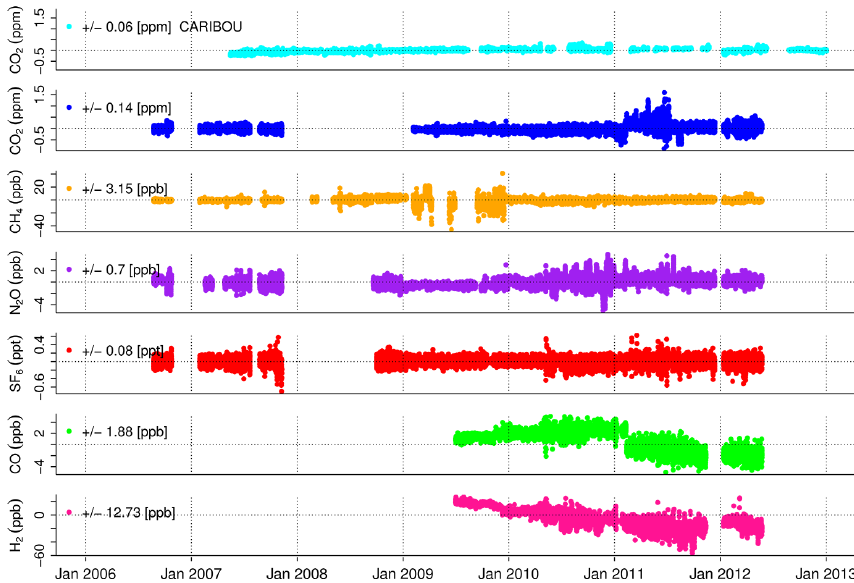
Figure 5. Long-term reproducibility of the target gases for CO 2 measured with the CARIBOU and for CO 2 , CH 4 , N 2 O, SF 6 , CO and H 2 measured with the coupled GC system. For all species the differences between measured data and their mean values are plotted against time. The drift of the target cylinder for H 2 can be explained by the elevated mole fraction of 841ppb which is greatly above the typical high ambient air values of 650ppb at Trainou. With our non-linearity test we were not able to correct such high